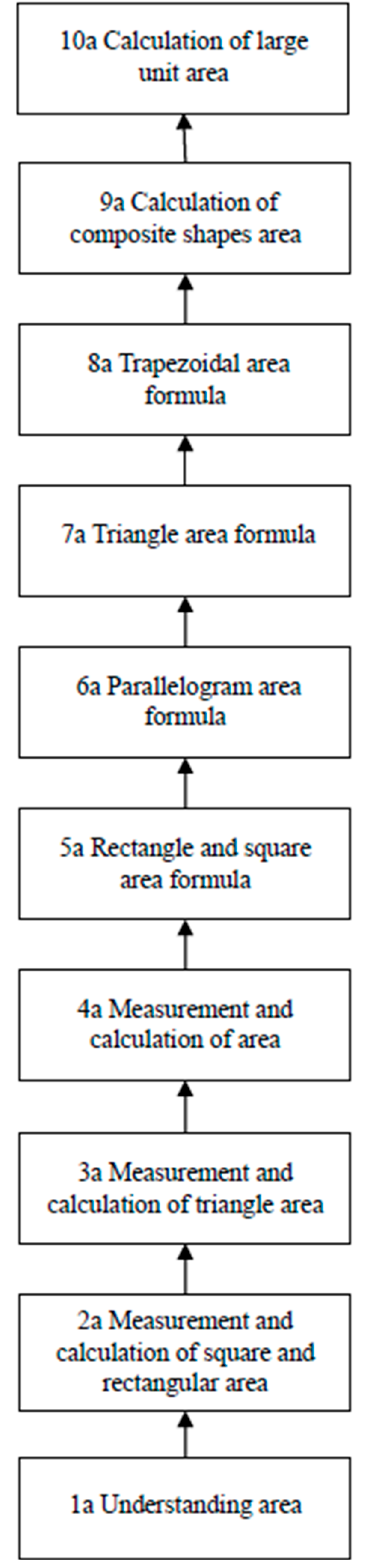
Figure 3. Gagné learning hierarchy diagram for the area computation unit. Figure 3. Gagn é learning hierarchy diagram for the area computation